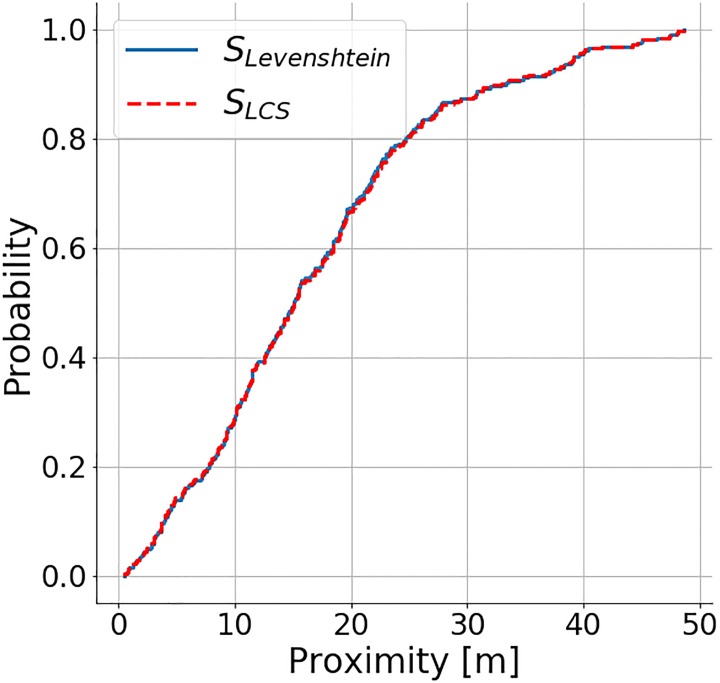
CDF of proximity (SLCS, SLD ≥ 0.9, proximity threshold ≤ 50m).